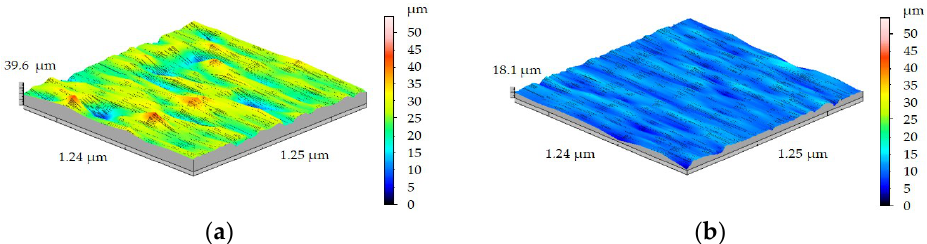
Figure 16. Results of 3D surface measurement samples after turning with f = 0.15 mm/rev of: ( a ) FEPA 046, ( b ) FEPA 100.